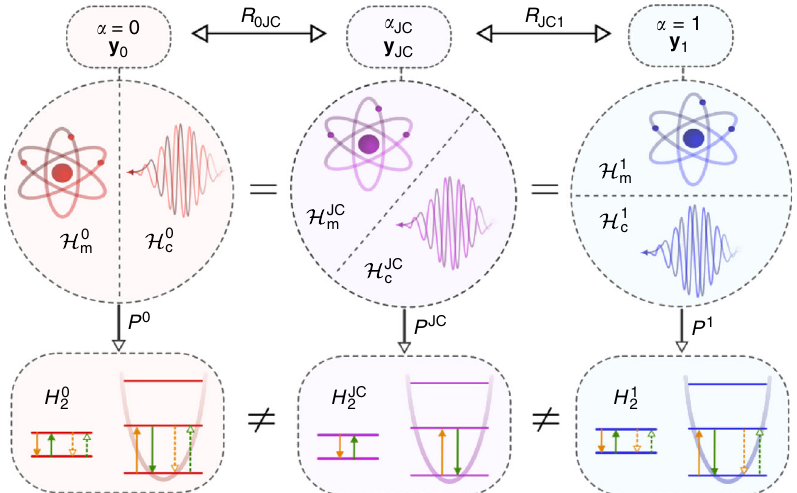
Fig. 1 Three important gauges and their non-equivalent two-level models. Shown are the α = 0, α = α JC and α = 1 gauges, and their associated two-level truncations. The different gauges are associated with different unitarily related canonical operators y subsystem decompositions of the light – matter Hilbert space. The composite Hilbert space and the Hamiltonian are unique, but a projection onto the fi rst two levels of the material system results in distinct two-level models with Hamiltonians H 0 model interaction Hamiltonians both have Rabi form and therefore describe real processes represented by the solid green and orange arrows, as well as counter-rotating processes represented by the dashed arrows. The α J C -gauge two-level model interaction has Jaynes – Cummings form and therefore all processes it describes are